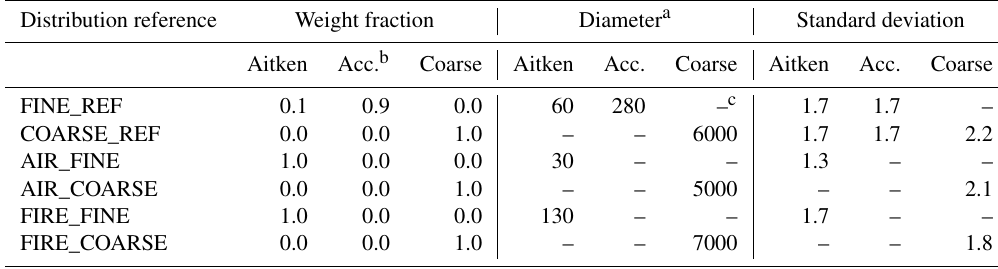
Table 9. Examples of aerosol size distributions available within CMAQ Distribution reference